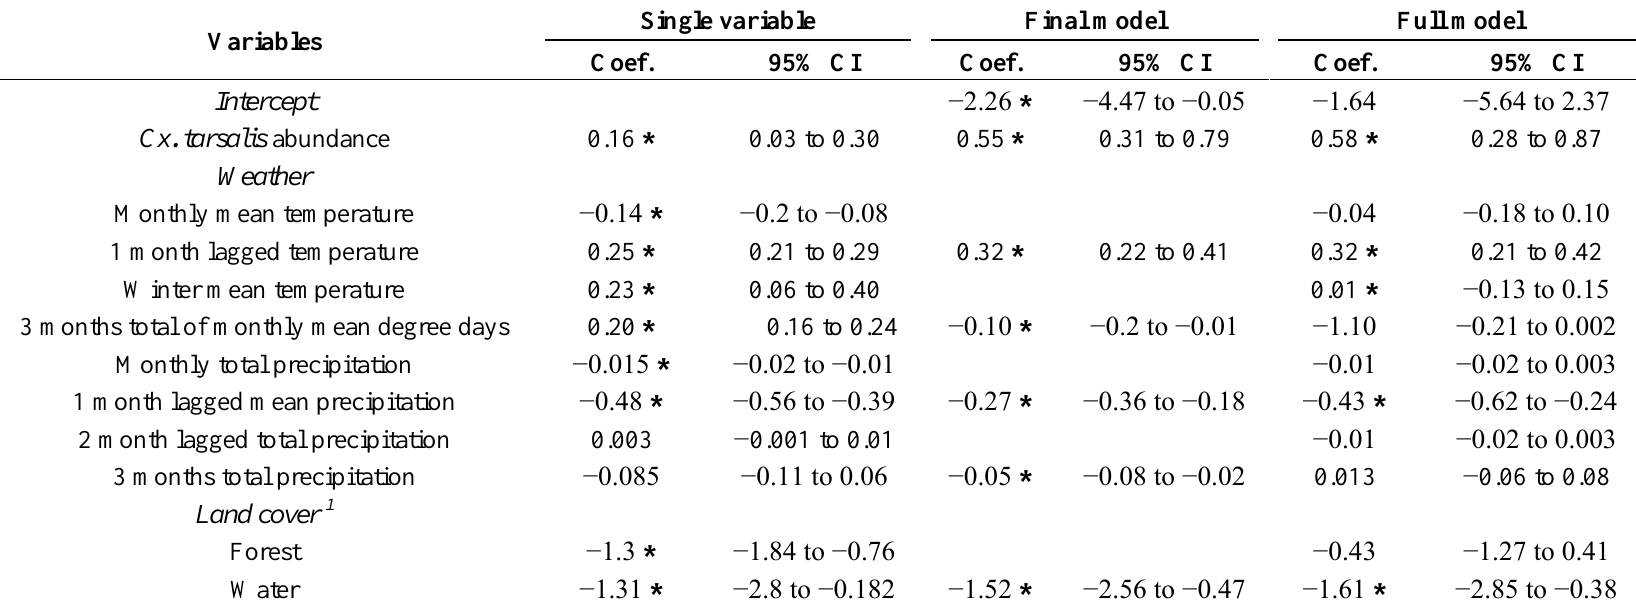
Table 3. Estimated coefficients of explanatory variables in the constructed models of WNV infection rate. Single variable indicates the explanatory variables which are assessed individually. Final model represents the final fitted model with the lowest AICc value. Full model is model fitted with all created explanatory